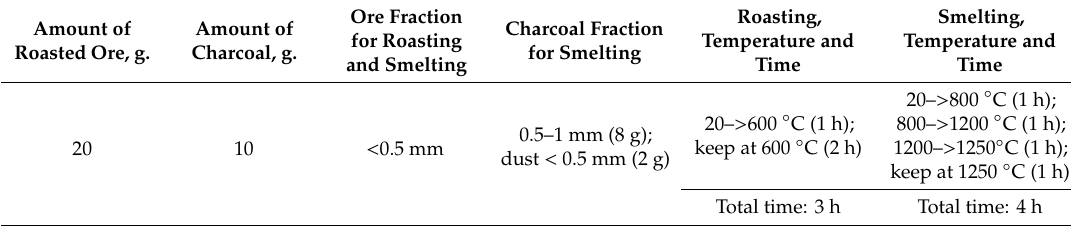
Table 2. The determined optimal parameters of iron ore smelting (assaying), using graphite crucibles and a muffle furnace.